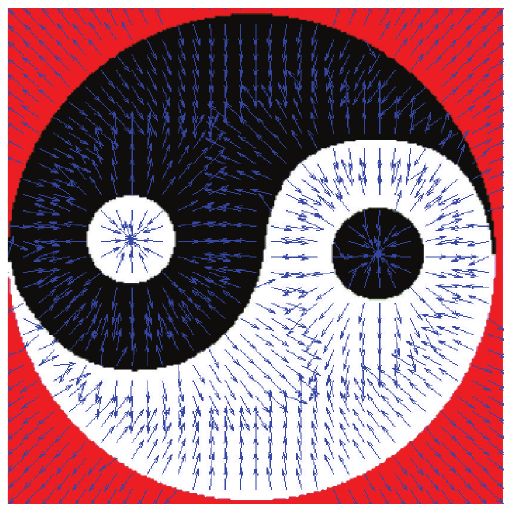
Figure 1: Input image and its corresponding GVF